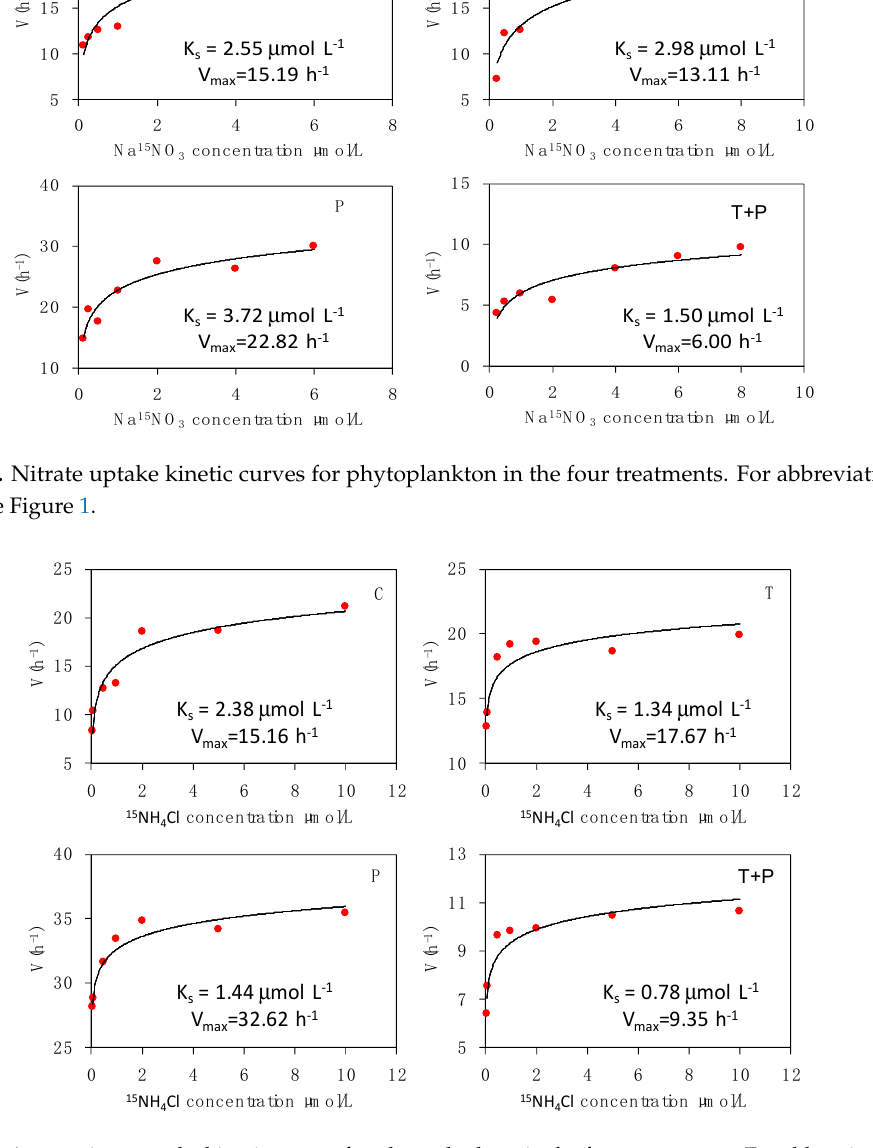
Figure 5. Ammonium uptake kinetic curves for phytoplankton in the four treatments. For abbreviations used, see Figure 1.